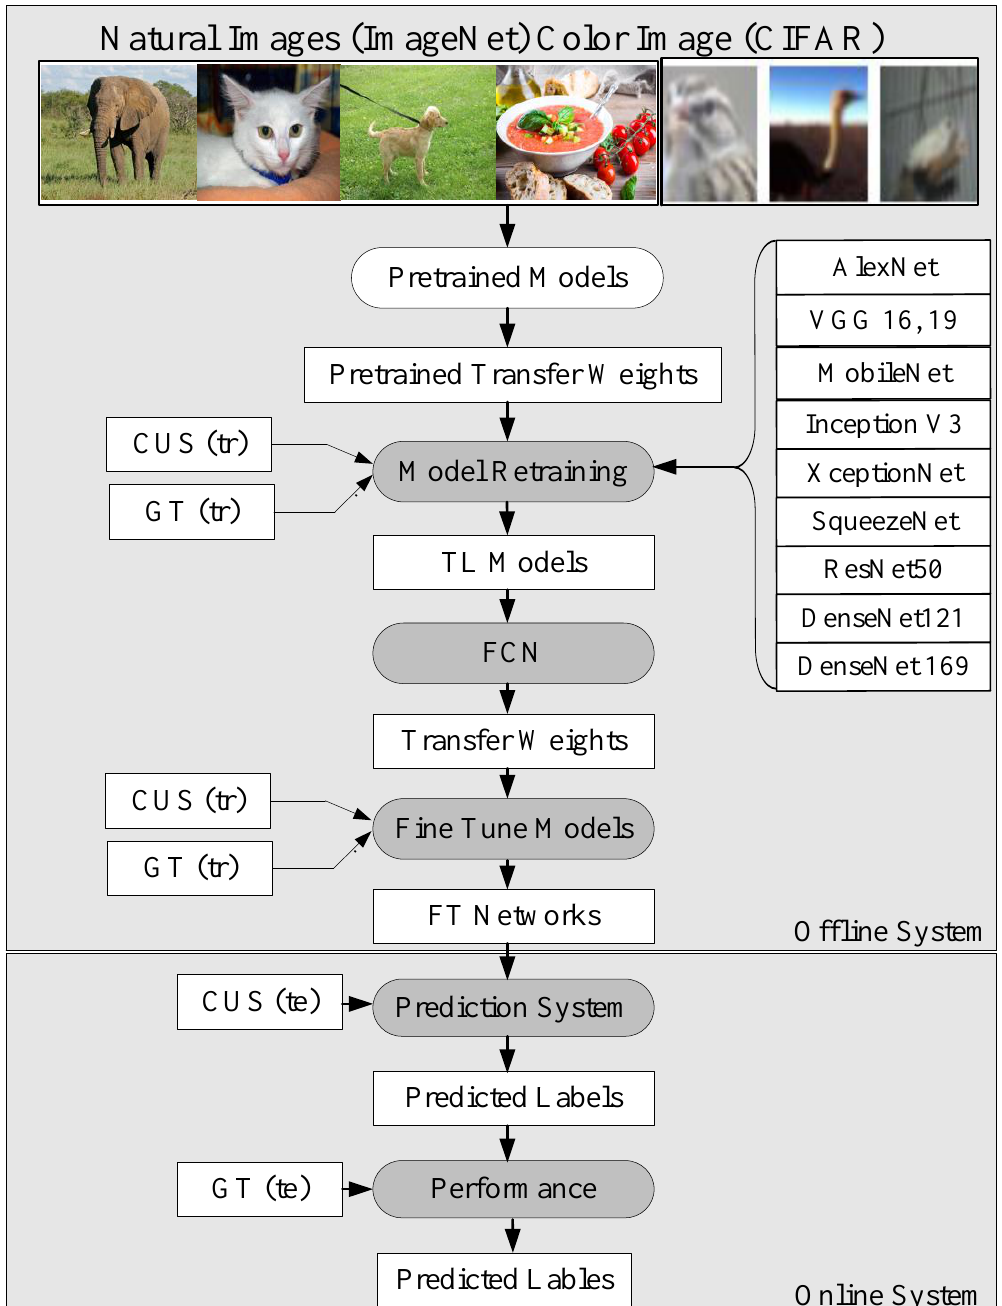
Figure 3. Global TL architecture using 10 different TL models ( i – ii ) Visual Geometric Group-16, 19 (VGG16, 19); ( iii ) Inception V3 (IV3); ( iv – v ) DenseNet121, 169; ( vi ) XceptionNet; ( vii ) ResNet50; ( viii ) MobileNet; ( ix ) AlexNet; and ( x ) SqueezeNet. Te stands for testing and tr stands for training. FN: fine-tune networks.